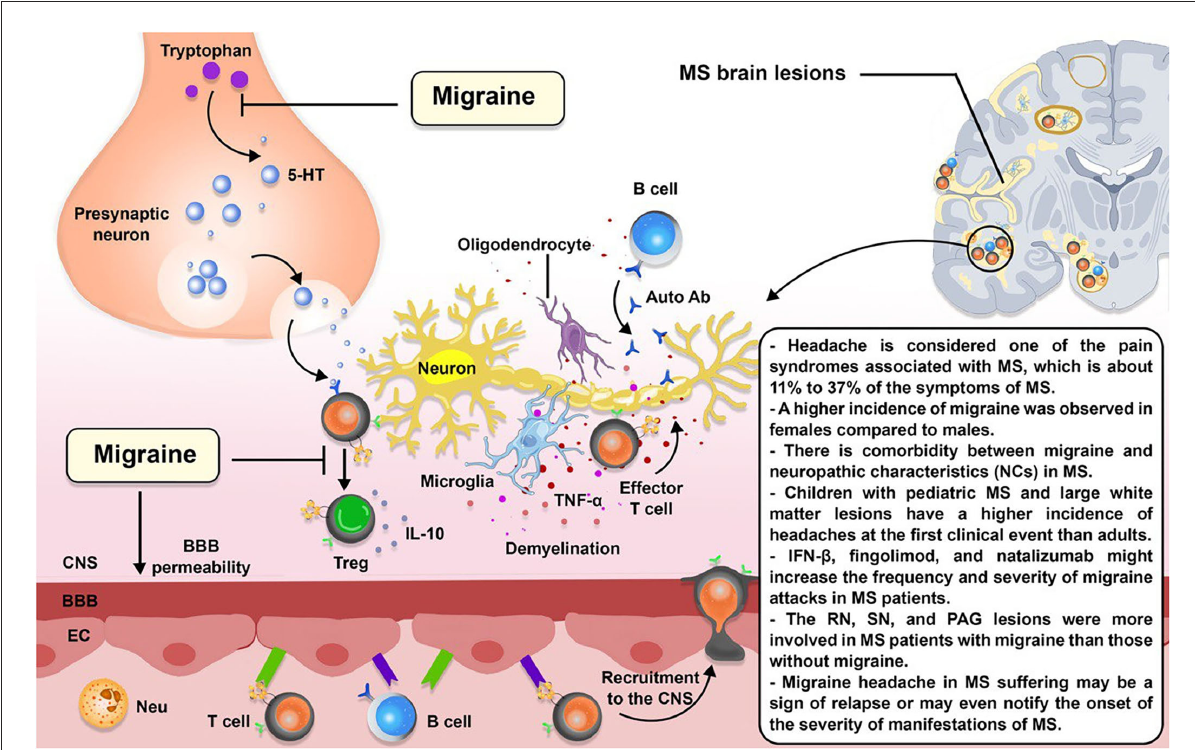
FIGURE3 The schematic illustration of the association between MS and migraine. Migraine is a forecaster of MS. 5-hydroxytryptamine (5-HT), a compound produced in the body from the tryptophan, is diminished during migraine headaches. 5-HT induces T cell differentiation to Treg cells; therefore, 5-HT deficiency may affect T cell differentiation toward effector T cells. 5-HT deficiencies may also be responsible for increased permeability of the blood–brain barrier (BBB), resulting in the recruitment of more inflammatory immune cells to the